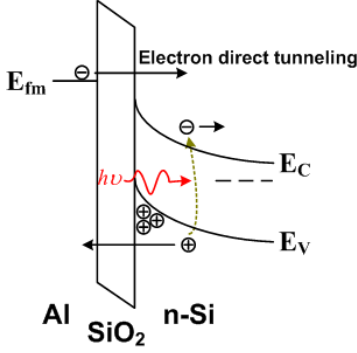
Figure 13. The schematic diagram of an Al/SiO photo-generated holes contributed to the first plateau of the photocurrent and the electron direct tunneling contributed to the second plateau [50].